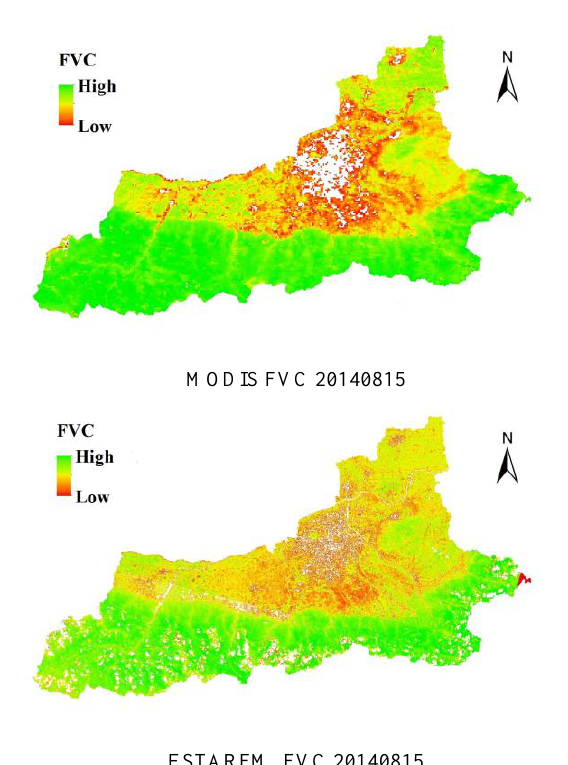
Figure 5. The distribution of impermeable layer at study